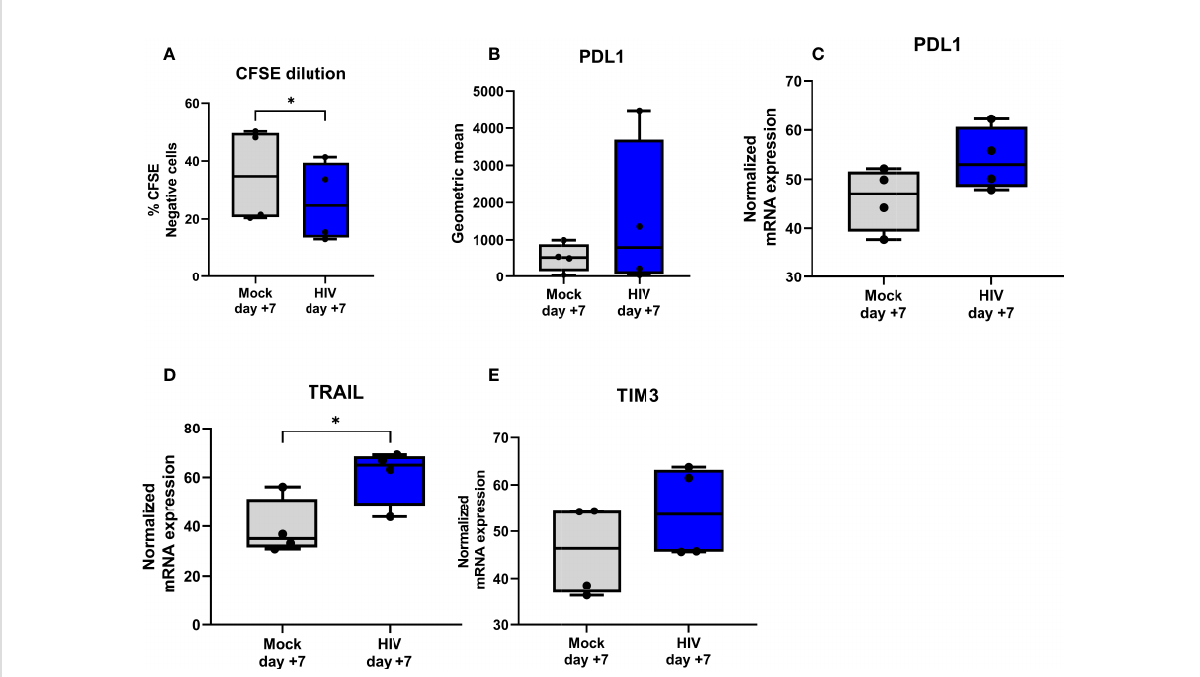
FIGURE 5 DCs separated from HIV exposed DC-T cell coculture can suppress priming of naïve T cells and induce expression of molecules associated with a tolerogenic DC and T cell phenotype. Mock or HIV exposed DCs was separated from DC-T cell cocultures after 24h culture and cultured with naïve T cells at 1:5 ratio (N= 4-6). After 7 days of culture proliferation was measured by CFSE dilution (A) and phenotype investigated on protein level by fl ow cytometry for PDL1 (B) and on gene level by qPCR for PDL1 (C) , TIM3 (D) and TRAIL (E) . The qPCR data was normalized as ratios of 100%. Shown are min to max and all data points. * P <0.05, unpaired